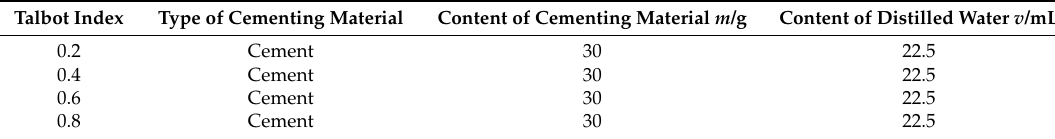
Table 4. Experimental program for prepared specimens.